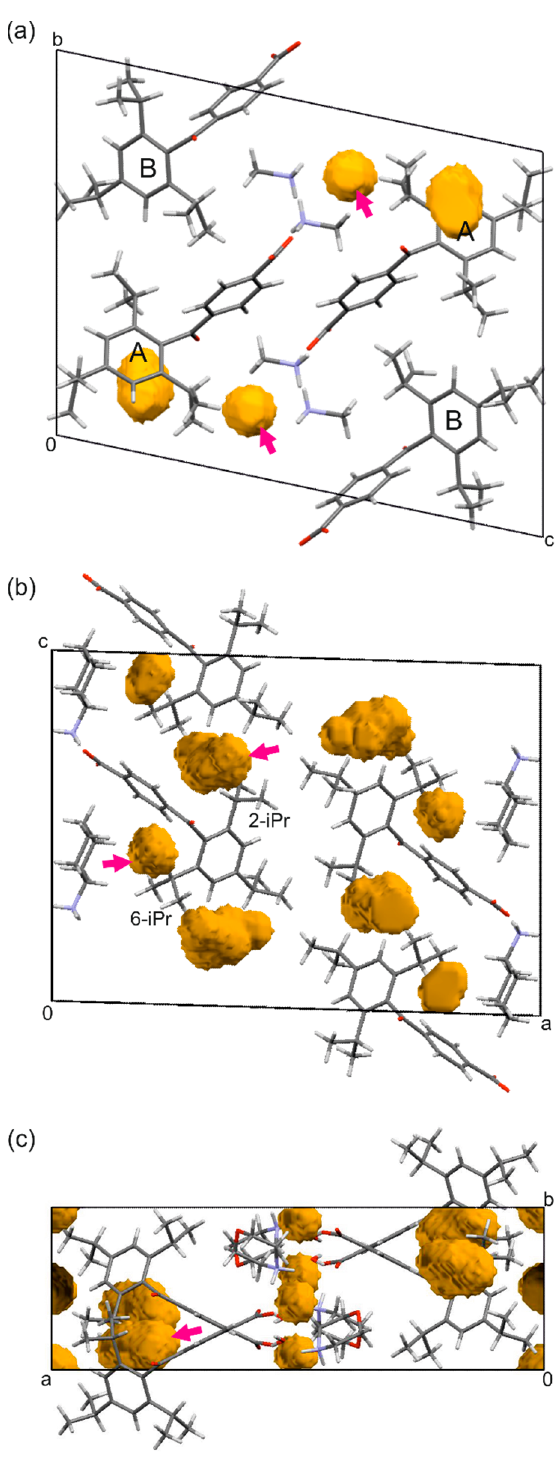
Figure 6. The free space in the crystals of compounds ( a ) ( 2 ) at 1.0 GPa; ( b ) ( 3 ) at 0.1 MPa; and ( c ) ( 4 ) at 0.1 MPa. The arrows show the voids in close proximity to o- isopropyl groups. The radius of a ball was 1.0 Å and the grid was 0.2 Å